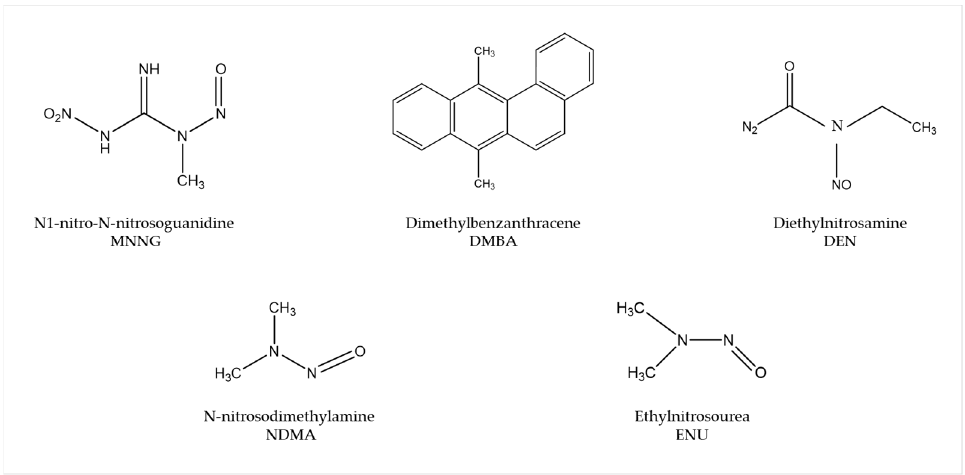
Figure 1. Most common carcinogenic substances used for tumor induction in zebrafish.